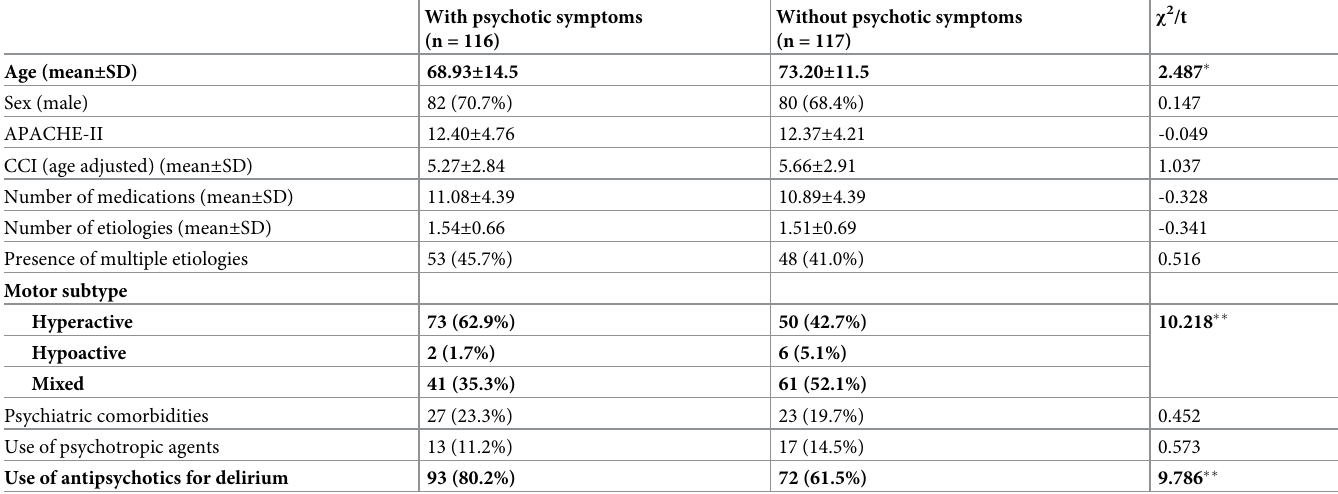
Table 1. Comparisons of demographic and clinical characteristics.